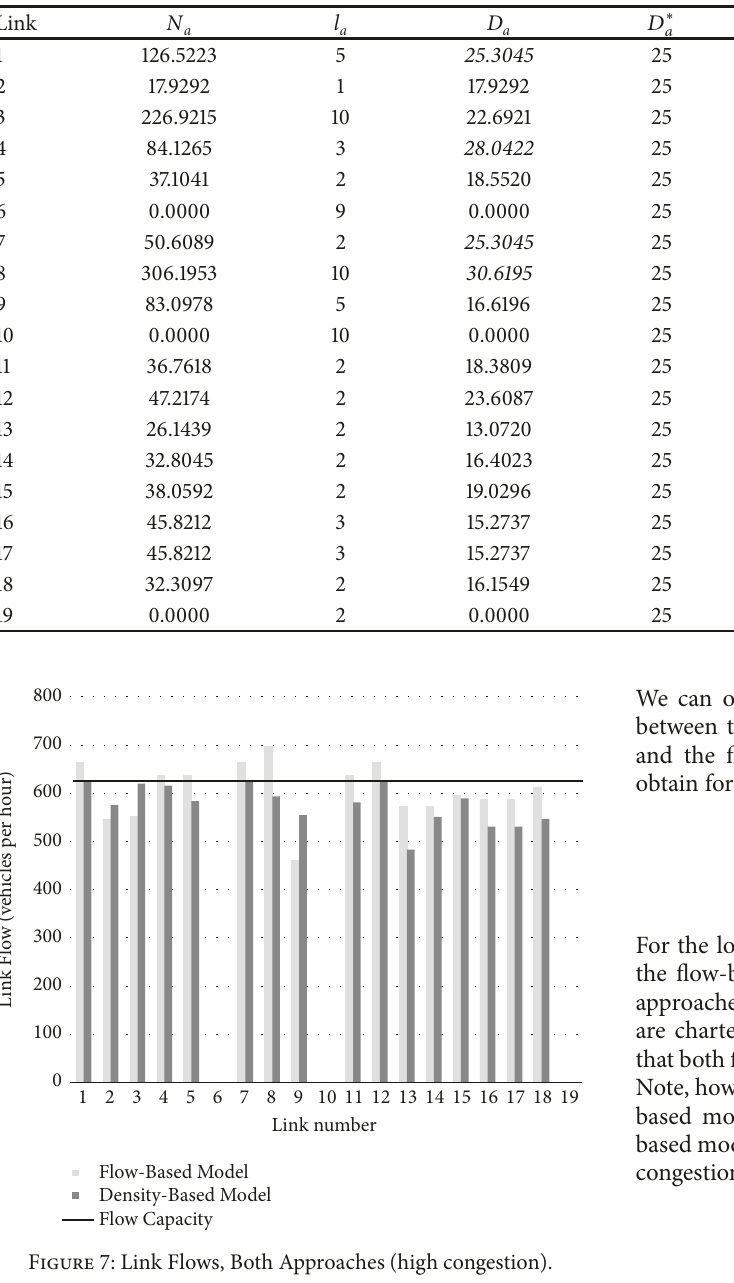
Table 4: Equilibrium Link Assignments, Density-Based Approach (high congestion).